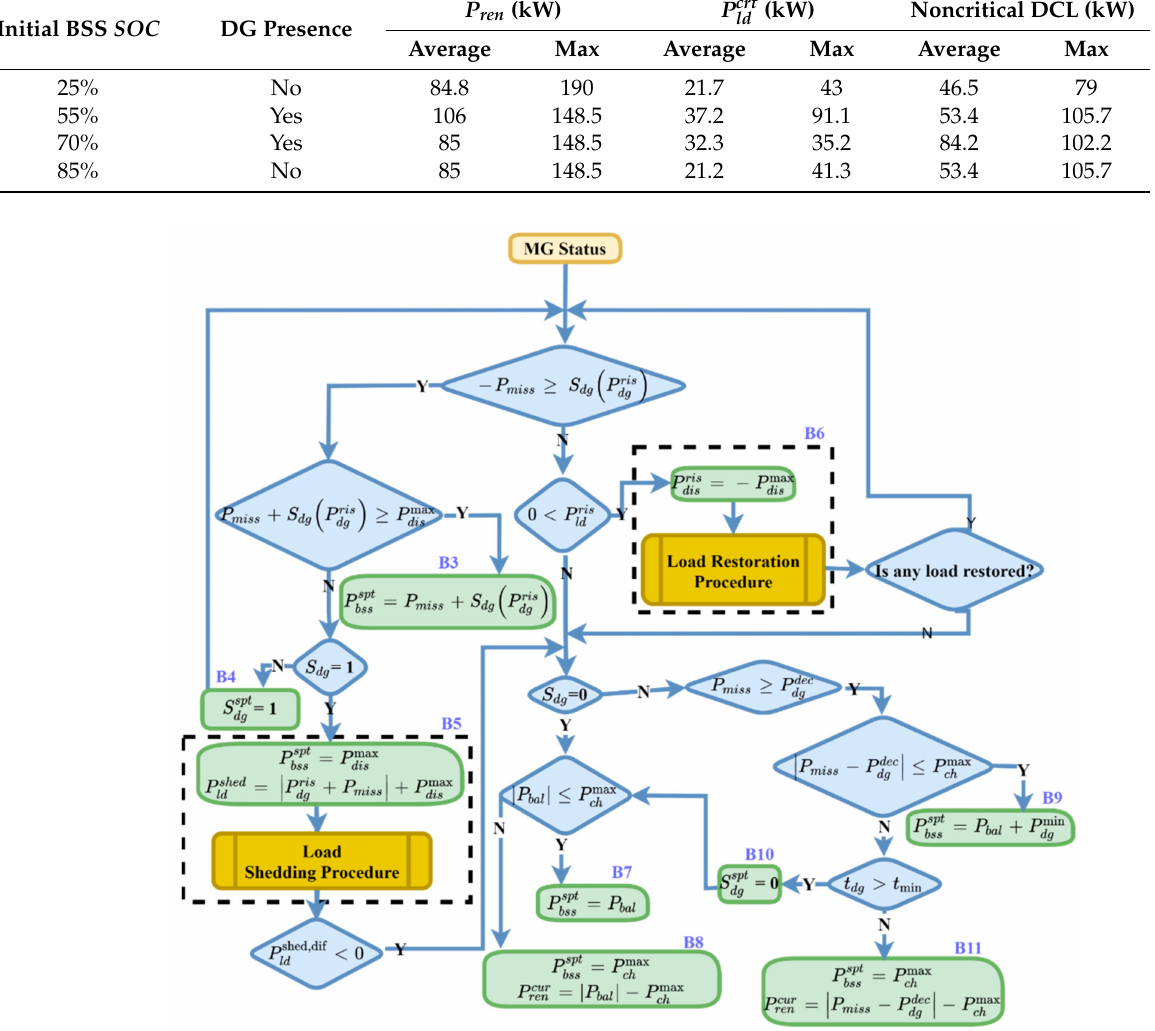
Figure 14. A non-SOC following rule-based dispatch